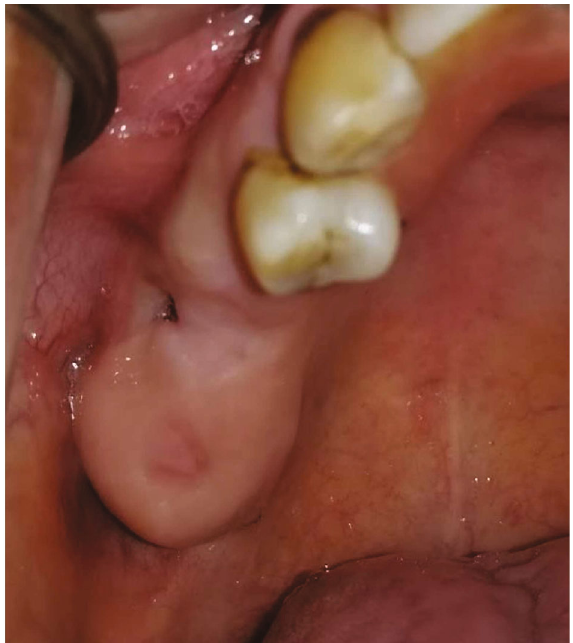
Figure 3: Intraoral view showing a 3mm diameter oroantral fi stula on the right maxillary